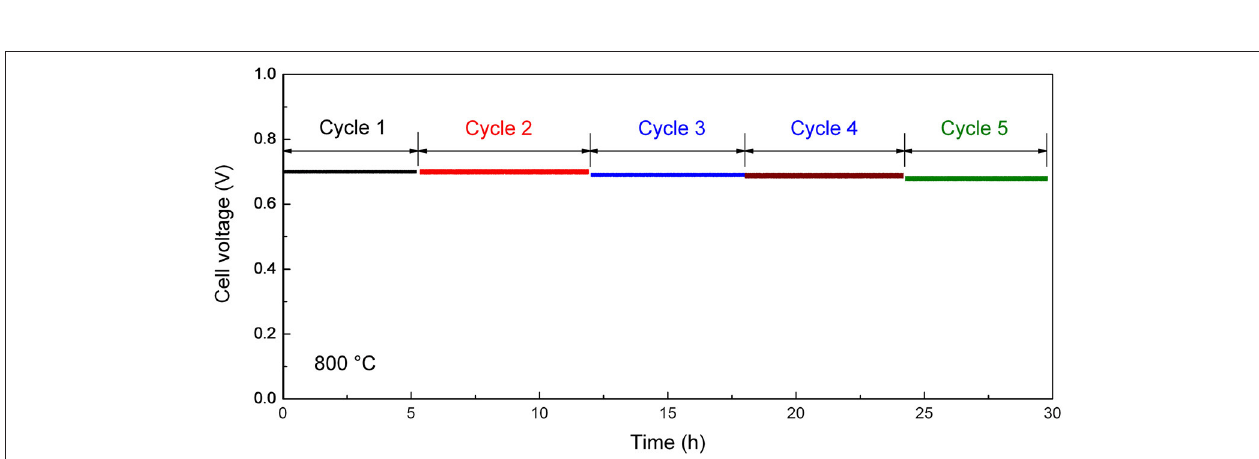
FIGURE 7 | (A) Current-voltage curves of the single cells with different cathode thicknesses, and (B) Maximum power density of the single cells as the function of cathode thickness.